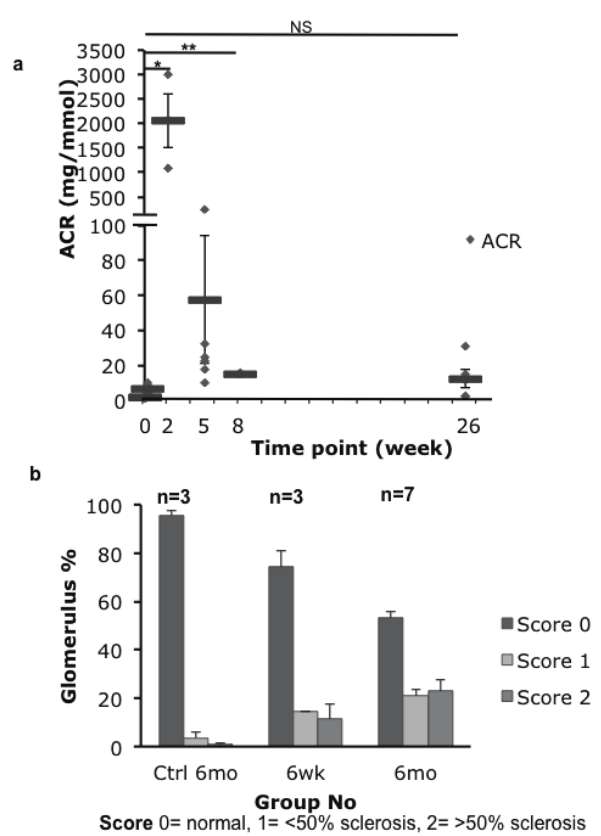
Figure 2. ( a ) Albumin:creatinine ratio (ACR) measured in urine of Podo-DTR line 47 at intervals after injection with 1ng/g bw. Acute proteinuria was highest at week 2 (mean value 2047.9mg/mmol) falling to much lower levels by 5 weeks (57.6mg/mmol) and ( b ) Glomerulosclerosis score of Podo-DTR line 47 mice at 6 and 26 weeks post DT injection at 1ng/g bw. 100 glomeruli were scored per animal (Uncropped gel image in Supplementary Figure